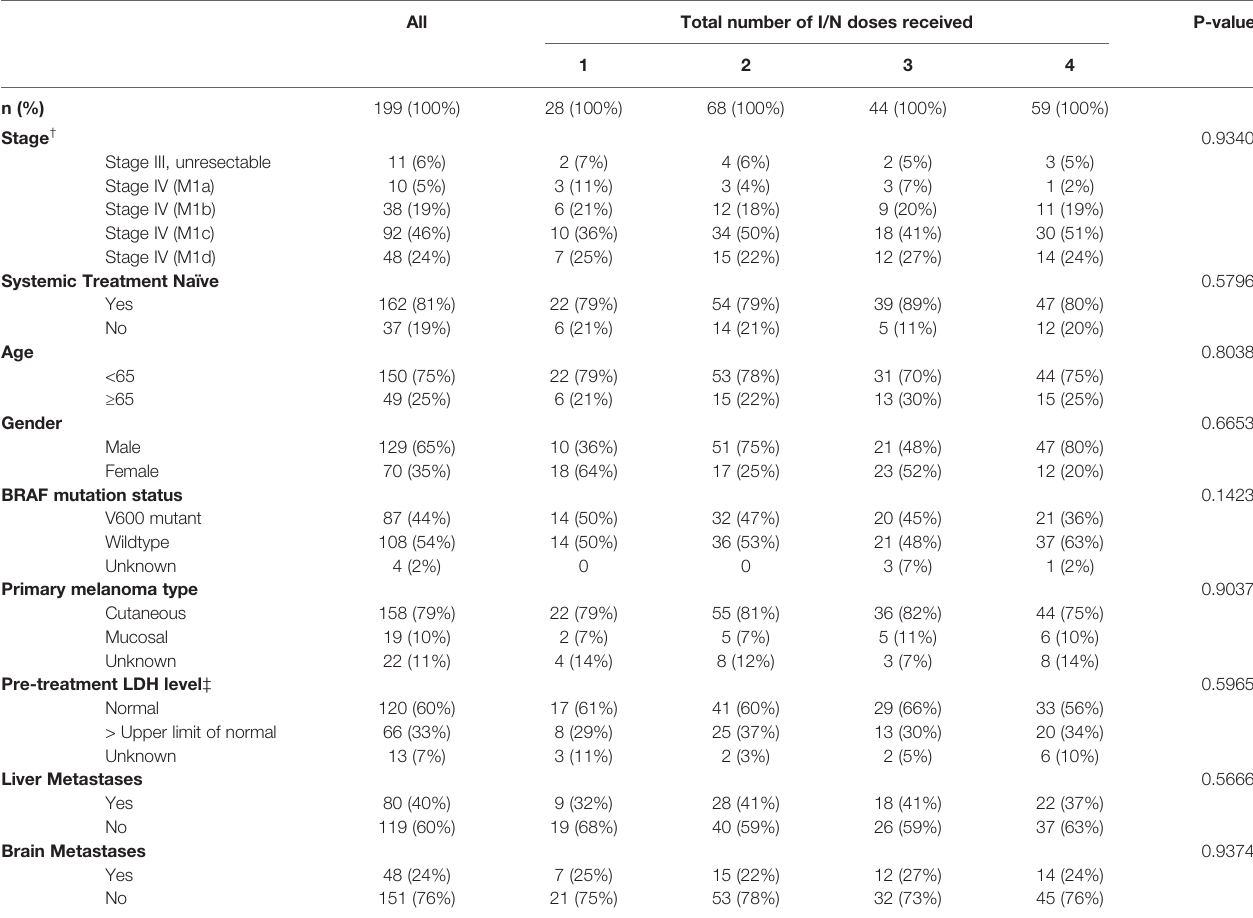
TABLE 1 | Patient